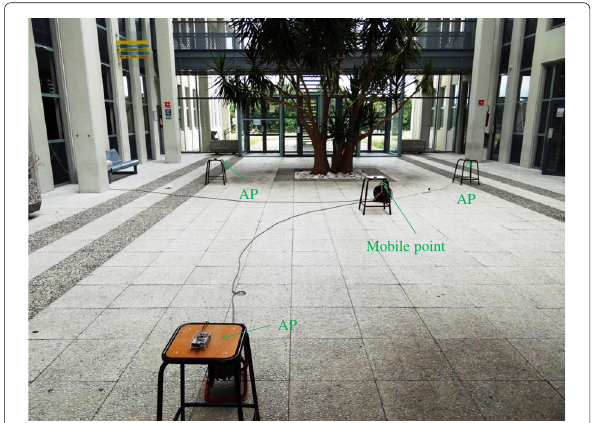
robot can only stop at one of the intersection dots of a grid. So the localization problem consists only in making a choice between the intersection points. The